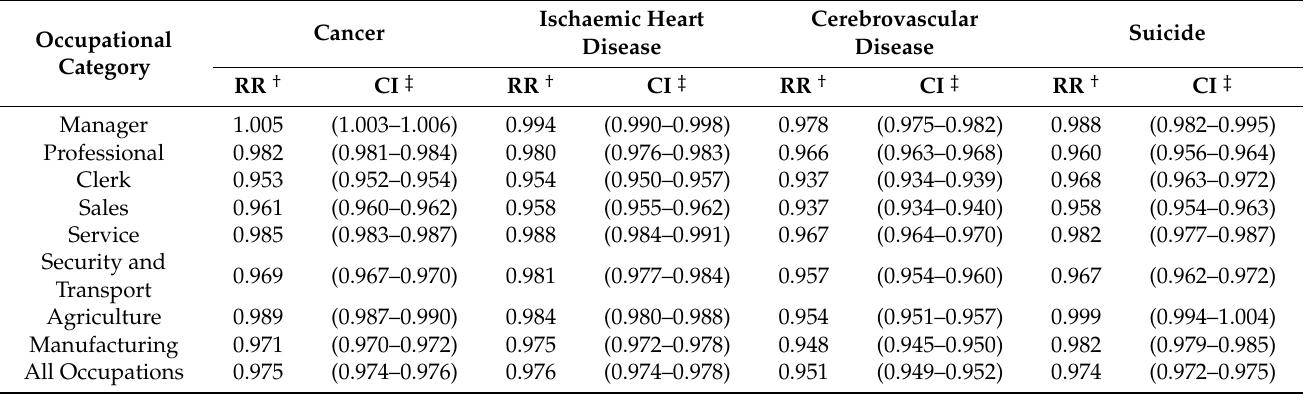
Table 2. Temporal trends by occupational categories for major causes of mortality from 1980 to